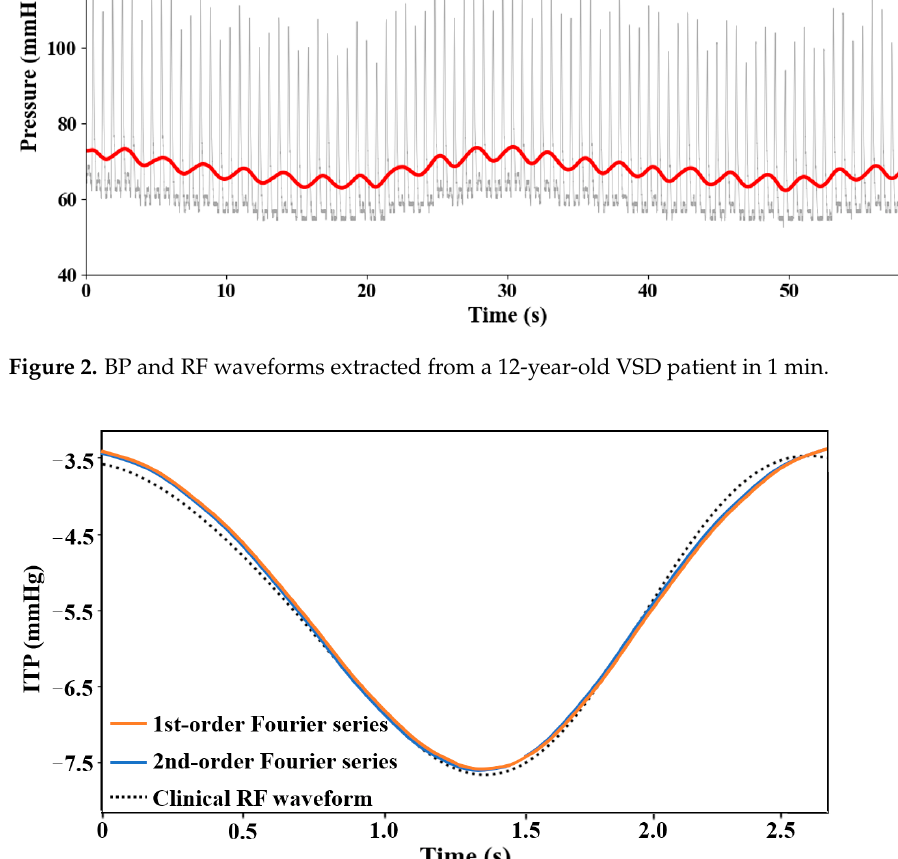
Figure 3. Comparison of fitting RF waveforms in a respiratory cycle between 1st-order and 2nd-order Fourier series approximations.